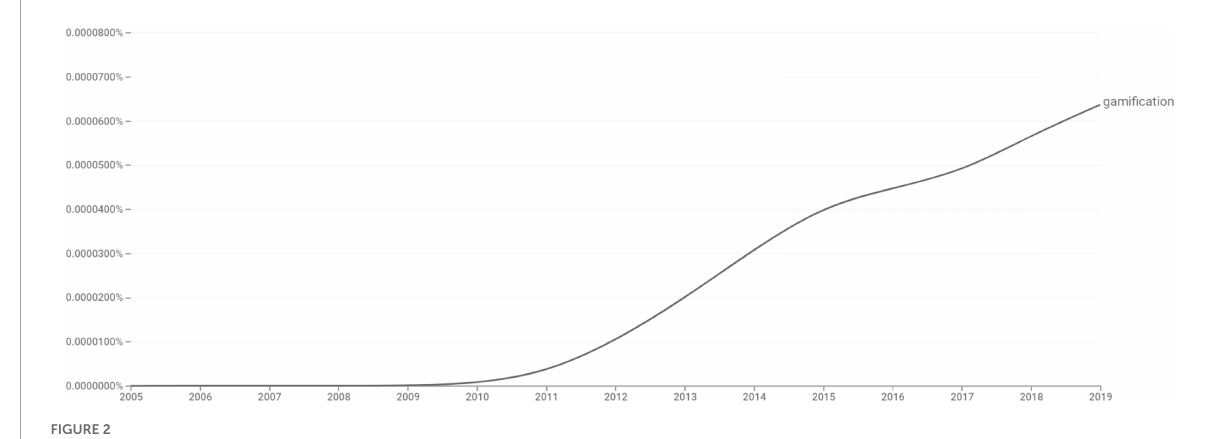
FIGURE2 Ngram analysis of the term “gamification” (author’s data).